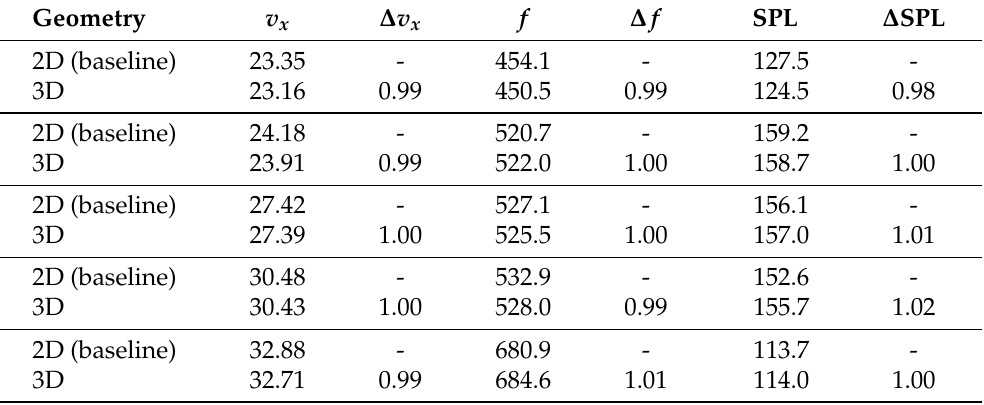
Table 3. Influence of a fully three-dimensional computational domain on velocity, shedding frequency, and sound pressure